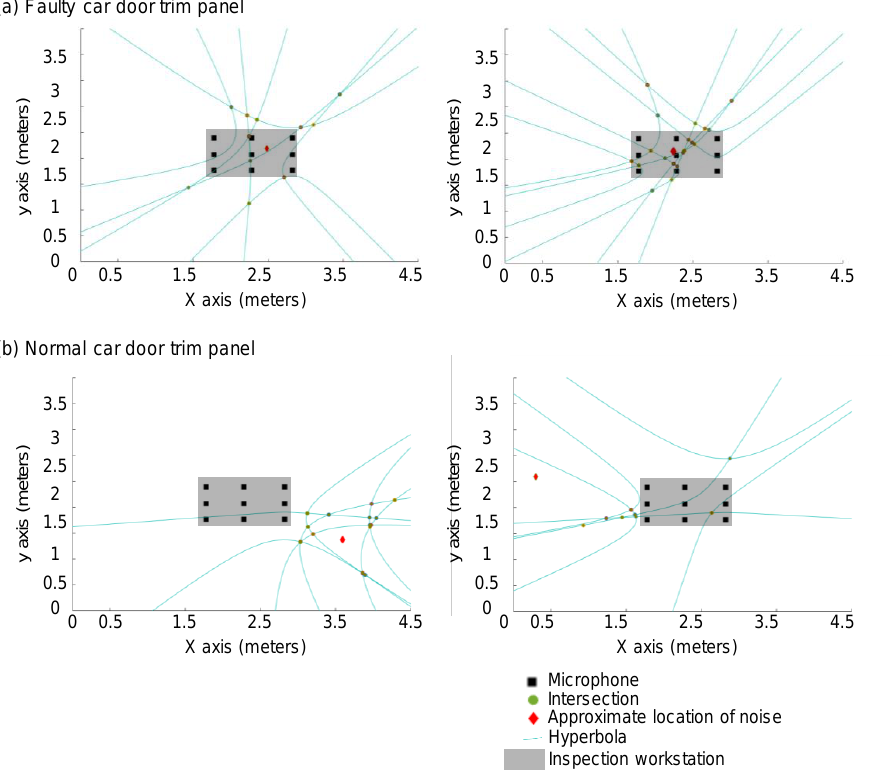
Figure 6. Examples of noise source localization. ( a ) Analysis of data of faulty car door trim: estimated location of noise is the inside of the inspection workstation. ( b ) Analysis of data of healthy car door trim: estimated location of noise is the outside of the inspection workstation.